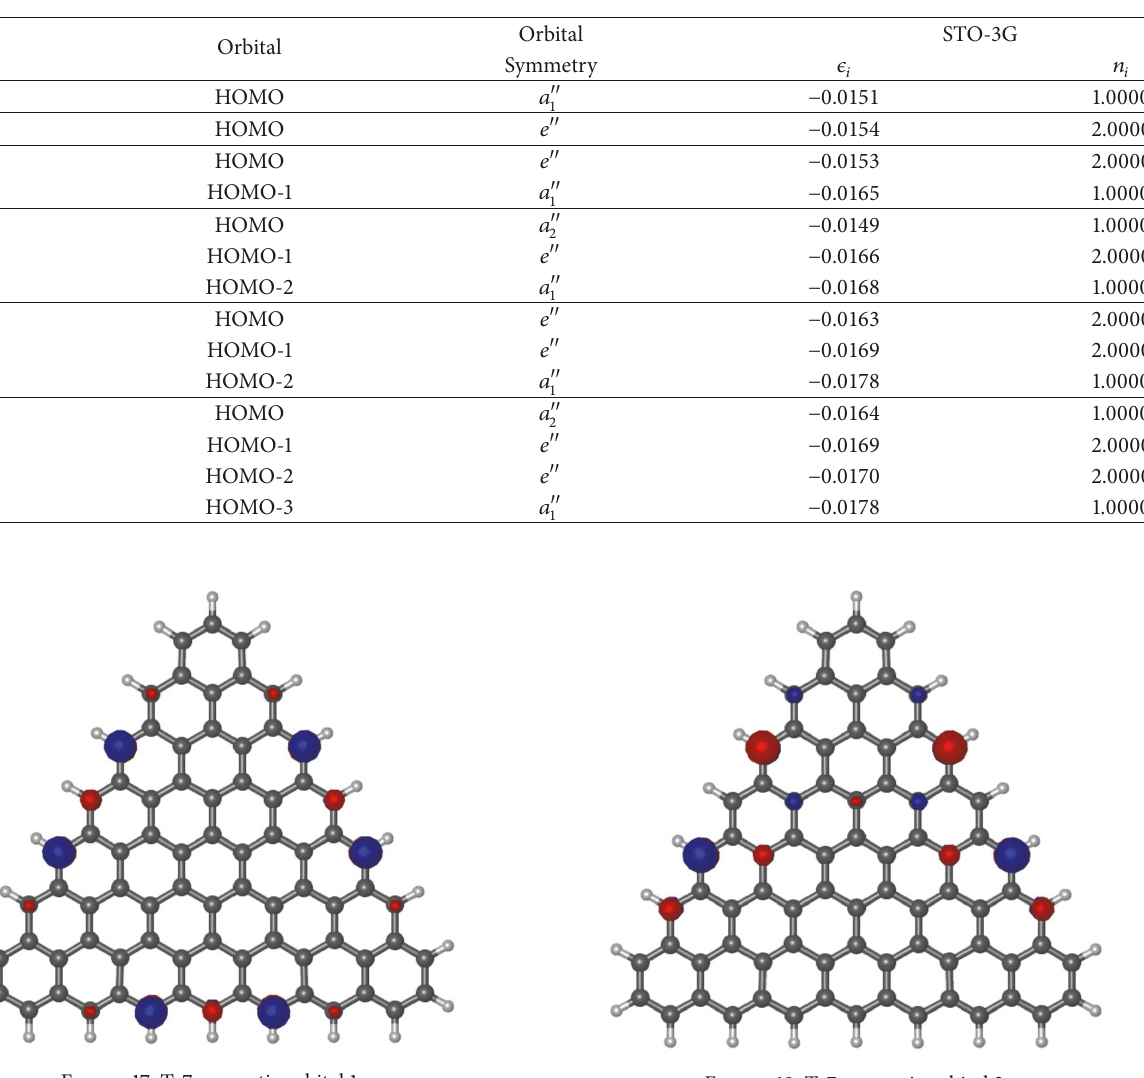
Table 9: Orbital energies ( 𝜖 𝑖 ) and occupancies ( 𝑛 𝑖 ) at RHF level for T n .